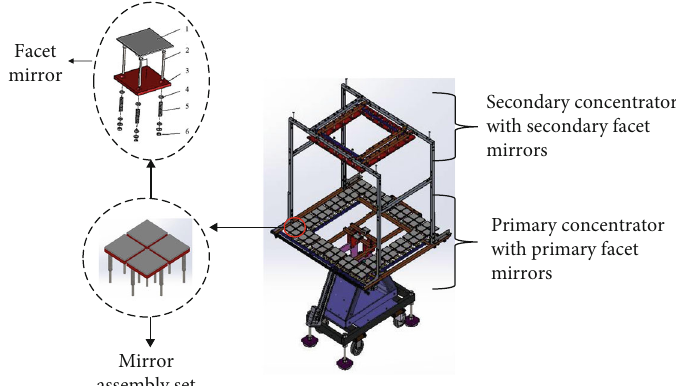
Figure 11: Active daylighting system consisted of two-stage nonimaging solar concentrator (2S-NISC) (source: adapted from